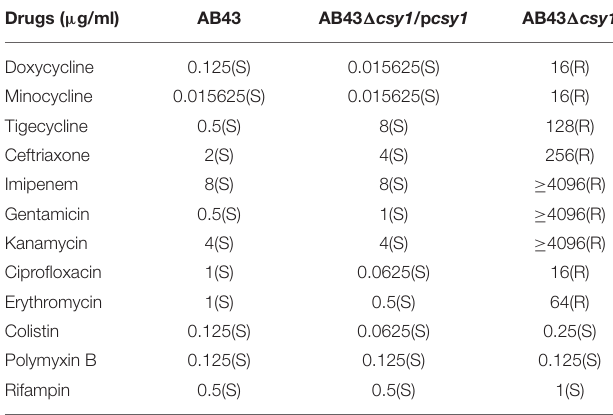
FIGURE 3 | The RNA level of csy1 gene in wild type (AB43), csy1 gene deletion (AB43 1 csy1 ), csy1gene complementation (AB43 1 csy1/pcsy1 ) strains. The RNA level in AB43 was set as 1, and those in strains AB43 1 csy1 and AB43 1 csy1/pcsy1 were calculated accordingly. Data are presented as means ± SEM from three independent experiments. ** p < 0.01. TABLE 4 | Minimum inhibitory concentrations (MICs) of AB43, complemented mutant, and 1 csy1 mutant strains to different antibiotics. Drugs ( µ g/ml)